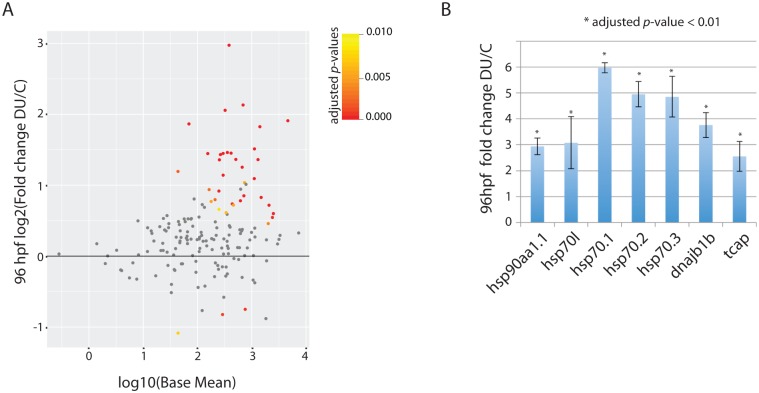
Induction of protein chaperones expression following myofibre damage in the 96 hpf larvae from DU-exposed adult zebrafish.(A) MA-plot focusing on the differential expression of the 169 genes involved in cellular stress (from the ache mutant, see Material and methods) and their regulation in 96 hpf larvae obtained from DU exposed. Significant adjusted p-values < 0.01 are indicated in red and yellow. (B) Log2 fold change of specific protein-chaperon in the skeletal muscles (all adjusted p-values (FDR) < 0.01; error-bars represent the standard deviation to the mean).